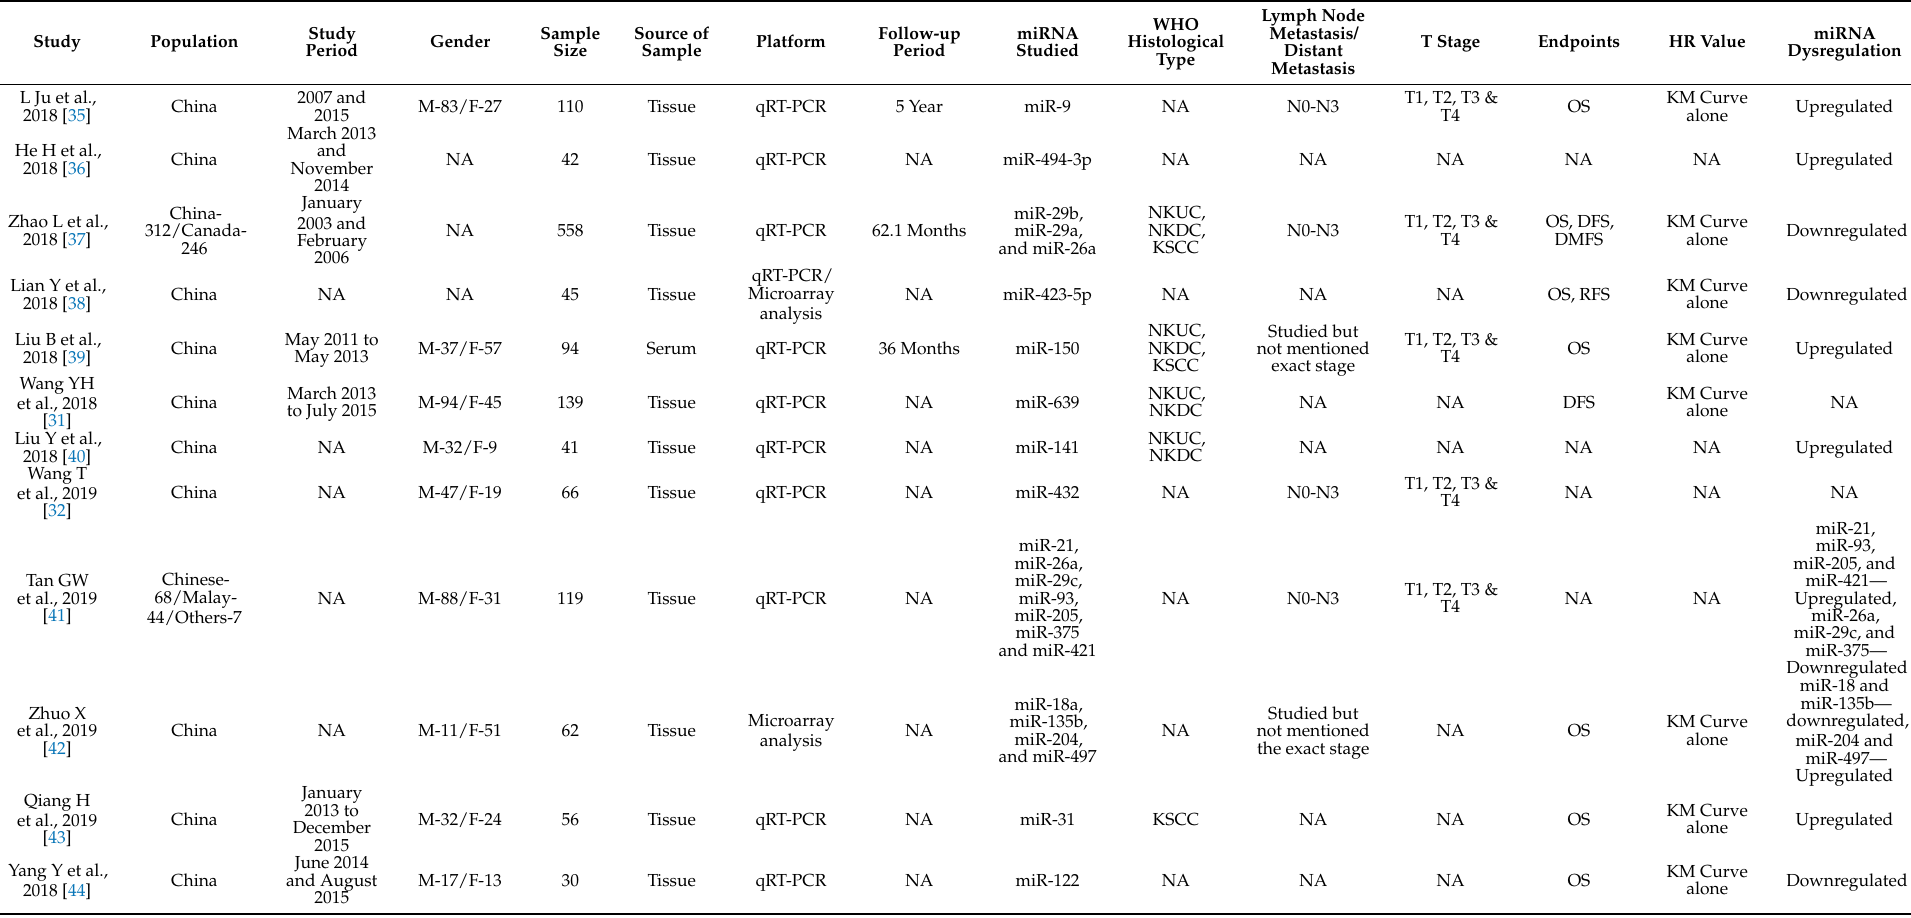
Table 2. The main features of the studies included in the systematic review and